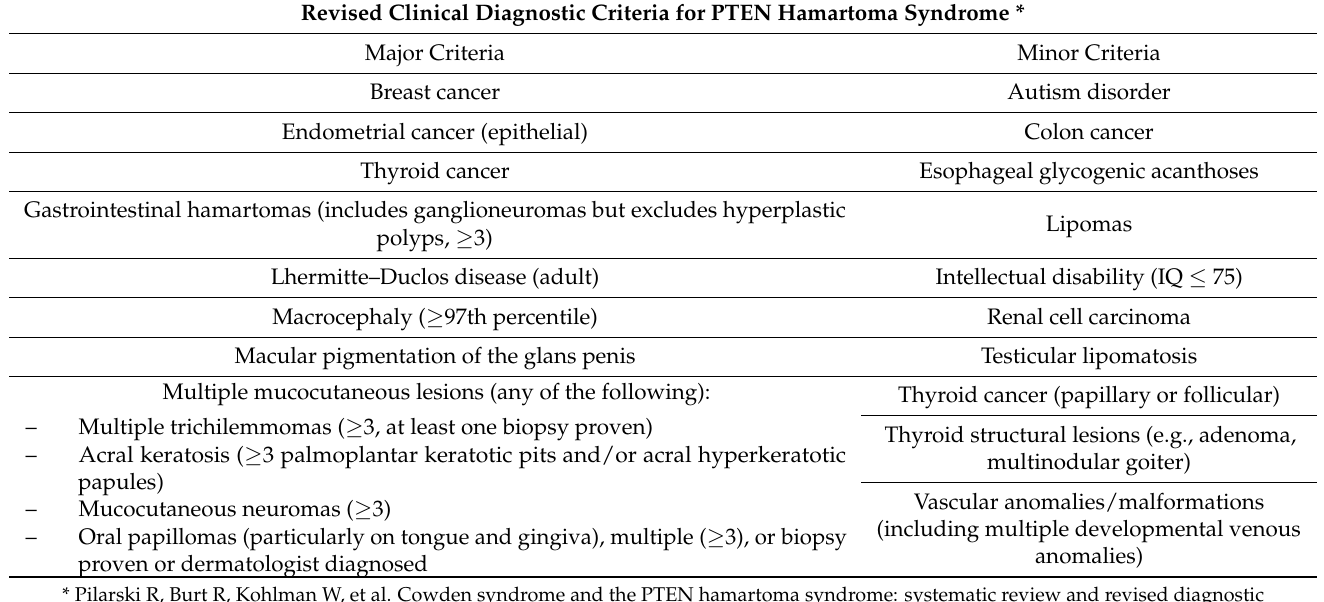
Table 2. Revised clinical diagnostic criteria for PTEN hamartoma syndrome adopted by NCCN, version 2.2021.